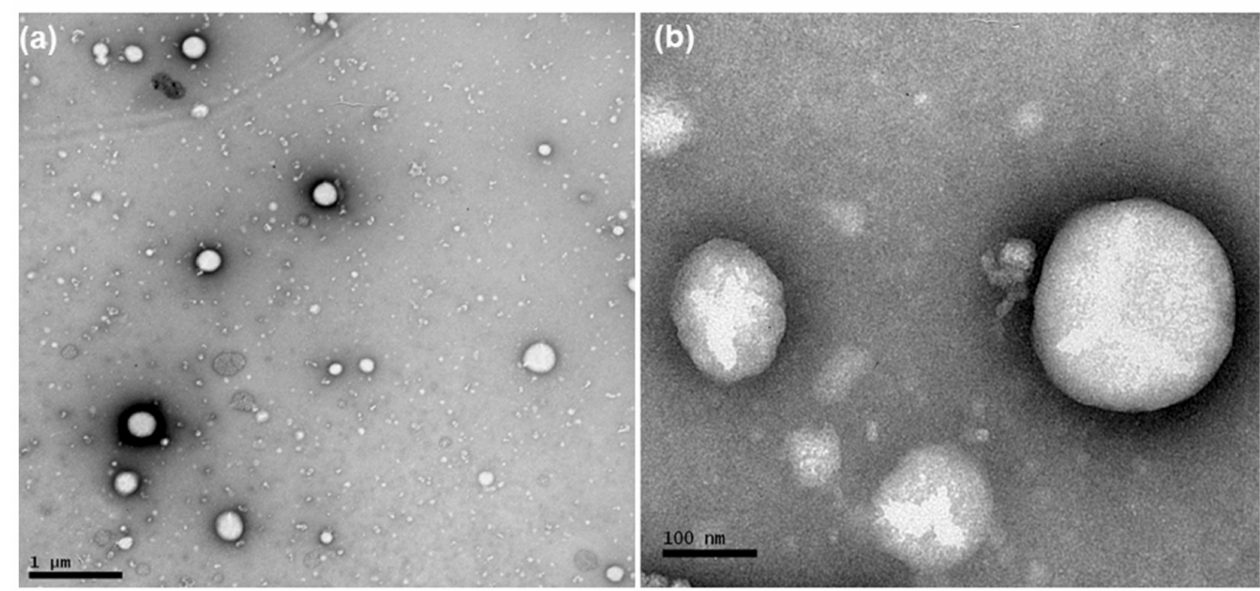
Figure 1. Photomicrographs obtained by transmission electron microscopy of AB-DOX-LNC-L-C-RGD: ( a ) bar = 1 µ m and ( b ) bar = 100 nm.